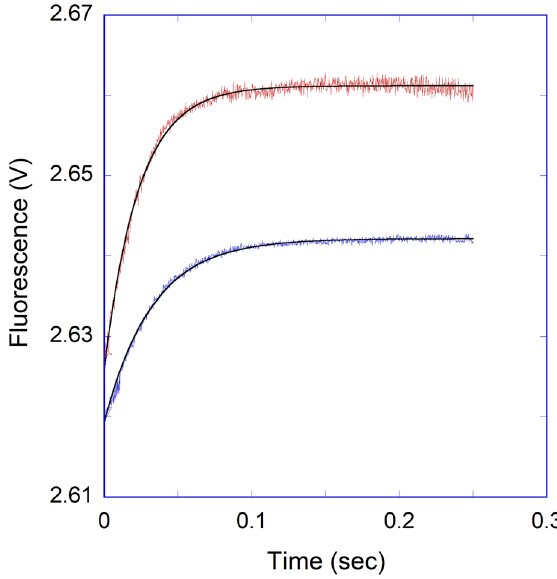
Figure 9. Iron decreases APP IRE mRNA·IRP1 binding by changing k on and k off . APP mRNA·IRP1 complex was diluted in the stopped-flow cell with an equal volume of the titration buffer alone, curve ( A ) and 50 μM Fe 2+ in the titration buffer, curve ( B ). Traces were best fit with the single-exponential function. The concentration of APP mRNA was 1 μM, and IRP1 was 0.1 μM after mixing. Data points were averaged from three independent experiments. The k off value was obtained from the K eq values and using K d = k off / k on .